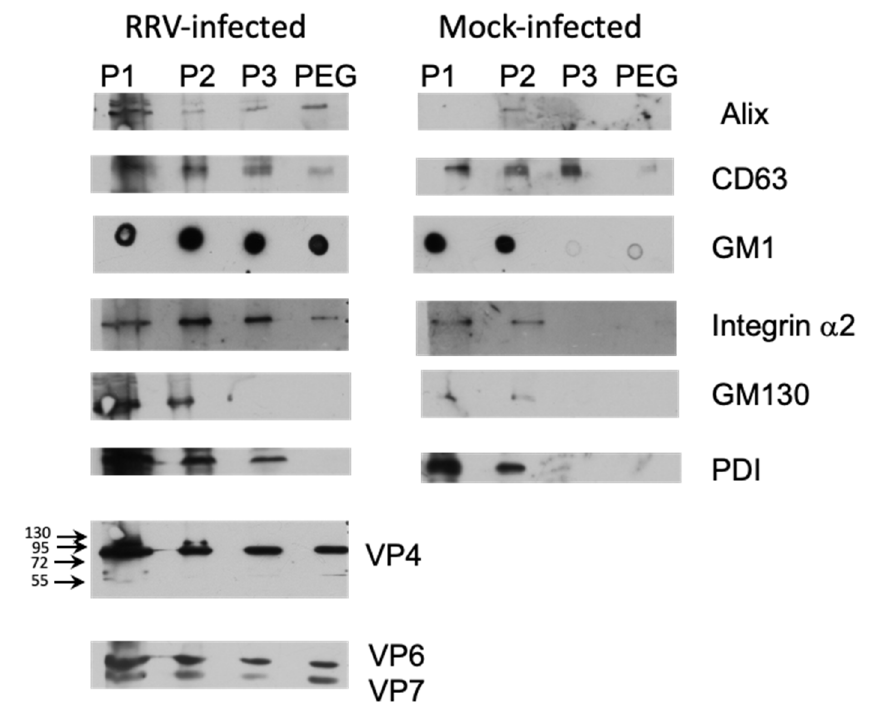
Figure 4. Presence of cellular markers and viral proteins in extracellular vesicles. Caco-2 cells were infected or mock-infected with strain RRV (MOI of 1) and at 18 hpi the supernatant was collected. Different fractions were obtained by differential centrifugation as described in material and methods; P1 at 500 × g , P2 at 2000 × g , P3 at 9600 × g and PEG fraction after PEG6000 addition. All pelleted fractions were resuspended in 100 µL of TNC, and proteins from equal amounts of sample were pelleted by methanol/chloroform method, resuspended in Laemmli loading buffer, and separated in 10% SDS-PAGE gels. After separation, the proteins were transferred to nitrocellulose membrane and probed by specific monoclonal or polyclonal antibodies as described in material and methods. For detection of ganglioside GM1, 3 µL of sample were directly blotted onto nitrocellulose, air-dried, blocked by 5% milk in PBS and detected using cholera-toxin B subunit conjugated with biotin, followed by streptavidin peroxidase. Where needed, molecular size markers are indicated. Final detection was done using the Western Lightning Chemiluminescence Reagent Plus (Perkin Elmer Life Sciences, Boston, MA).